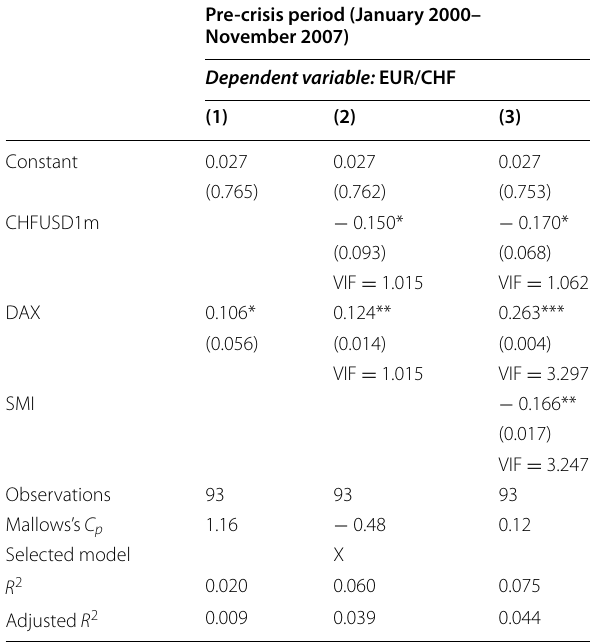
Table 2 OLS regression results for the pre‑crisis